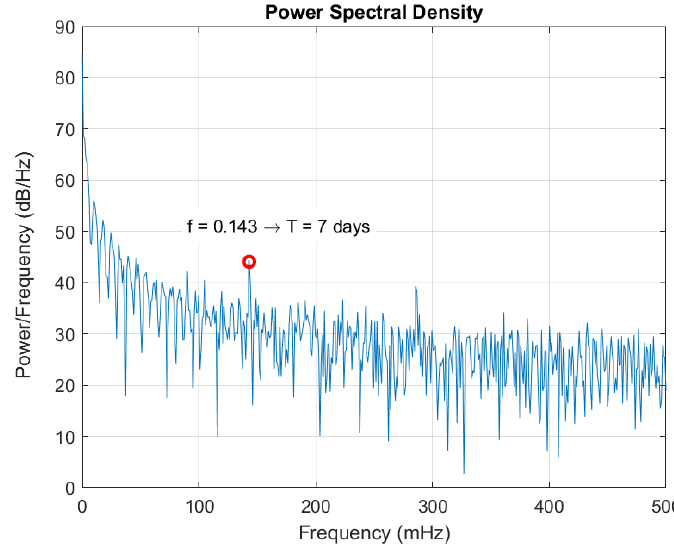
Figure 11. Power spectral density for the daily energy demand between 2016–2018.